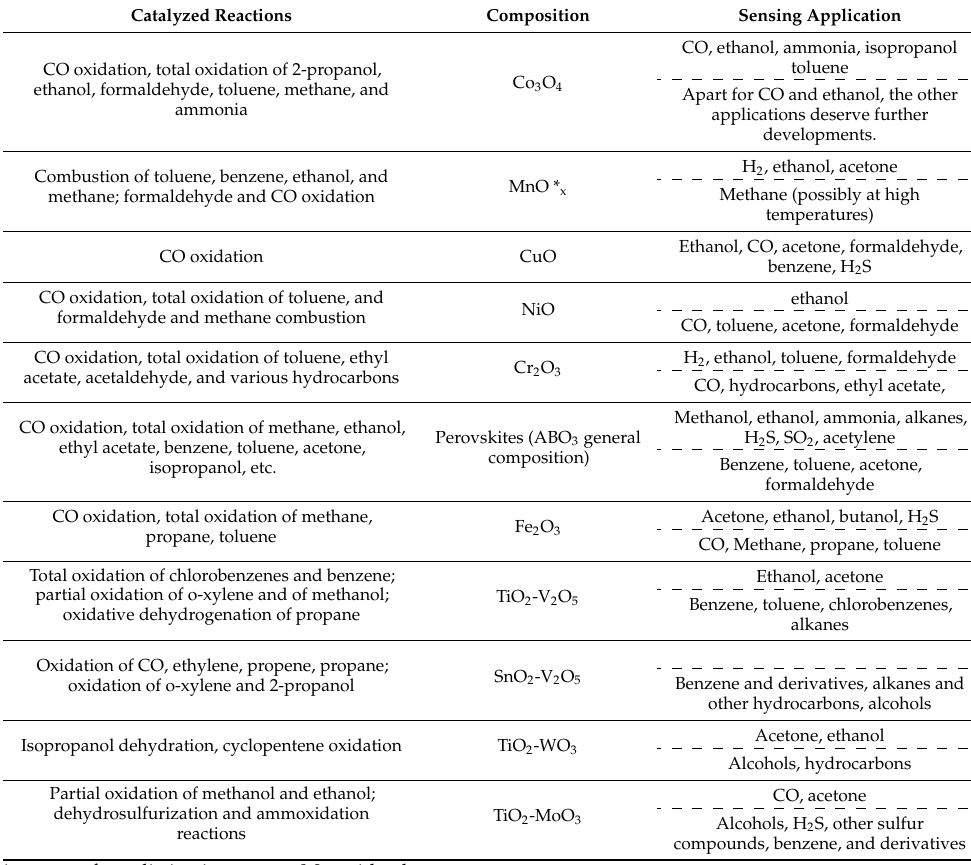
Table 1. The left column reports examples of catalyzed reactions by the metal oxides reported in the adjacent column. The right column reports known and suggested and/or scarcely explored (cell below the dashed line) sensing